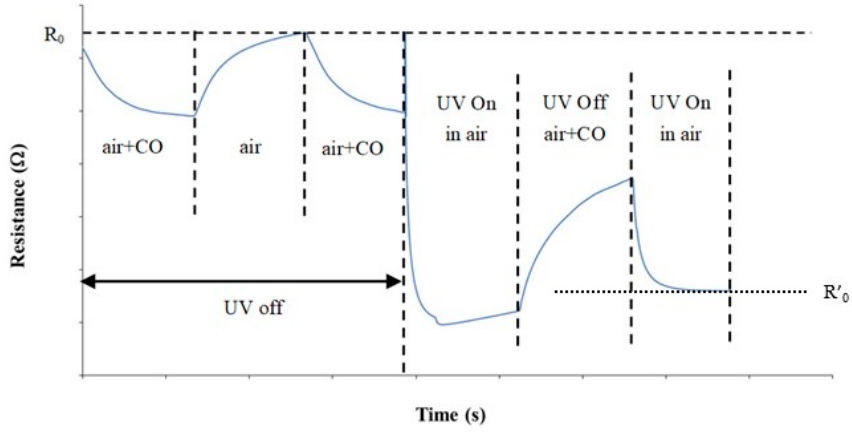
Figure 10. Transient sensor response in “UV Off” mode and “UV On in air” mode. (T = 100 °C, 10 ppm CO).